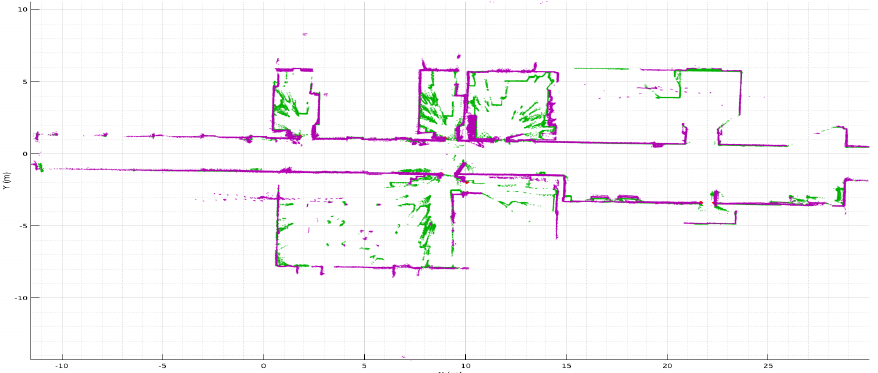
Figure 13. Overlapped